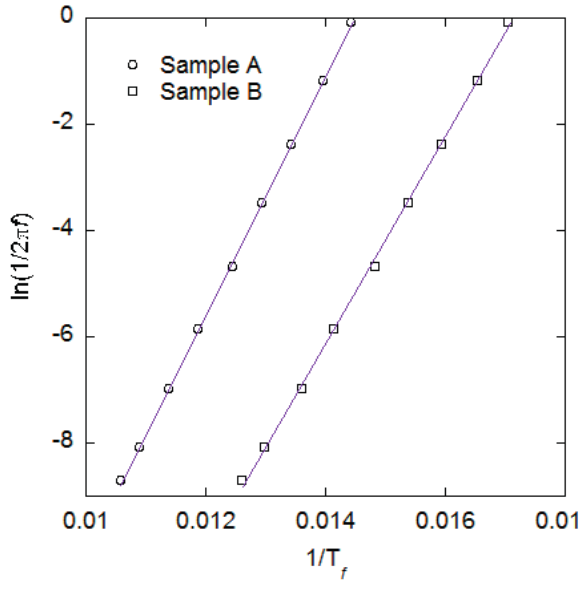
Figure 8. Data extracted from the ACS versus temperature measurements for samples A and B. Data have been fitted using straight